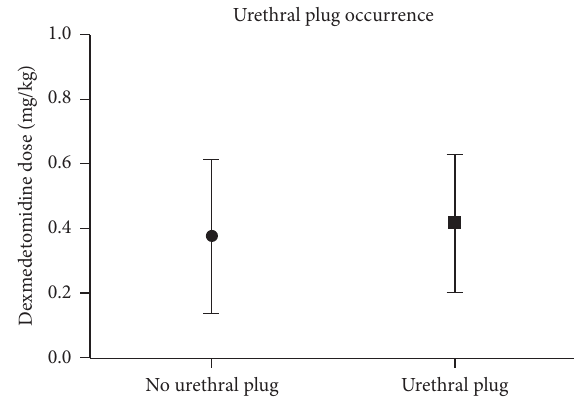
Figure 1: Seminal coagulum plugs occurred at dosages ranging from 0.05 to 0.8mg/kg. No significant differences were noted in the occurrence of a urethral plug based on the dosage of dexmedet- omidine ( 𝑝 = 0.61 ). Data are presented as the mean ±